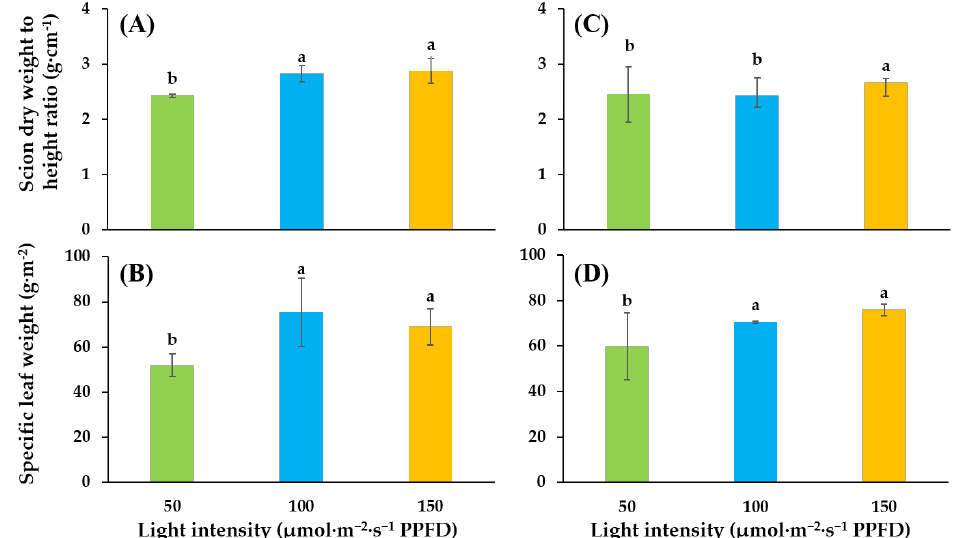
Figure 2. Influence of supplementary lighting intensity on dry weight to height ratio of scion and specific leaf weight of two cultivars of tomato ‘SS’ ( A , B ) and ‘SD’ ( C , D ) grafted onto ‘B-Blocking’ rootstock. The error bars represent SEs of biological replicates ( n = 9). According to the Duncan test, lowercase letters at p ≤ 0.05 indicate significant differences between different treatments.